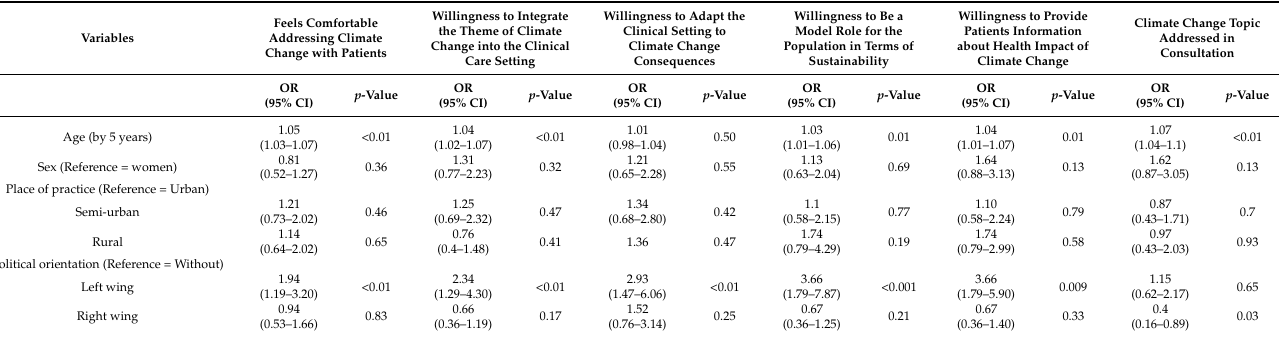
Table 3. Odds ratio of the multivariable logistic